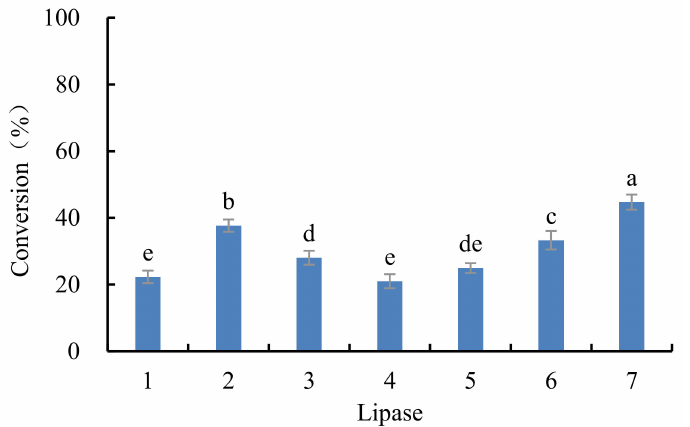
Figure 1. The conversion of EGCG by different lipases (reaction conditions: EGCG, 1 mmol; vinyl stearate, 3 mmol; enzyme, 5.0% ( w / w of all substrates)); reaction temperature, 40 ◦ C; reaction time, 48 h in acetonitrile. 1: Novozym 435; 2: TLIM; 3: PSIM; 4: RMIM; 5: RM; 6: AY “Amano” 30SD; 7: DF “Amano” 15. Bars with different letters are significantly different at p < 0.05.